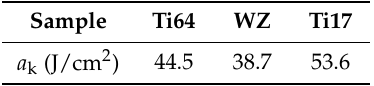
Table 3. Impact toughness of WZ and base metals.